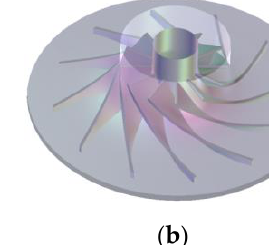
Figure 5. The impeller of the optimal design of the S-CO 2 centrifugal compressor: ( a ) rotor’s meridian face profile and ( b ) 3-D model of the impeller.